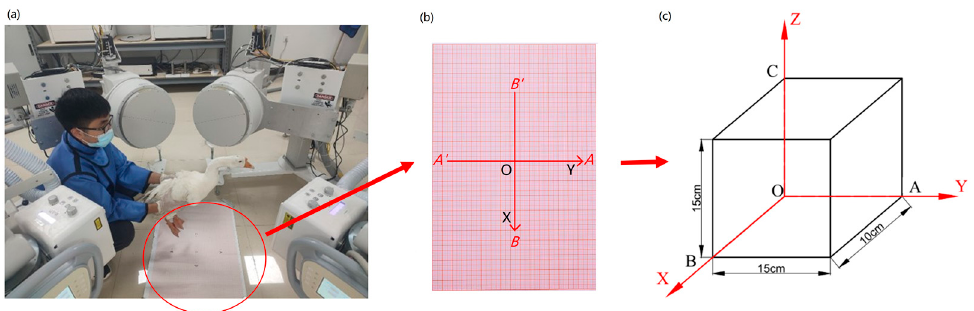
Figure 2. Systematic error correction.